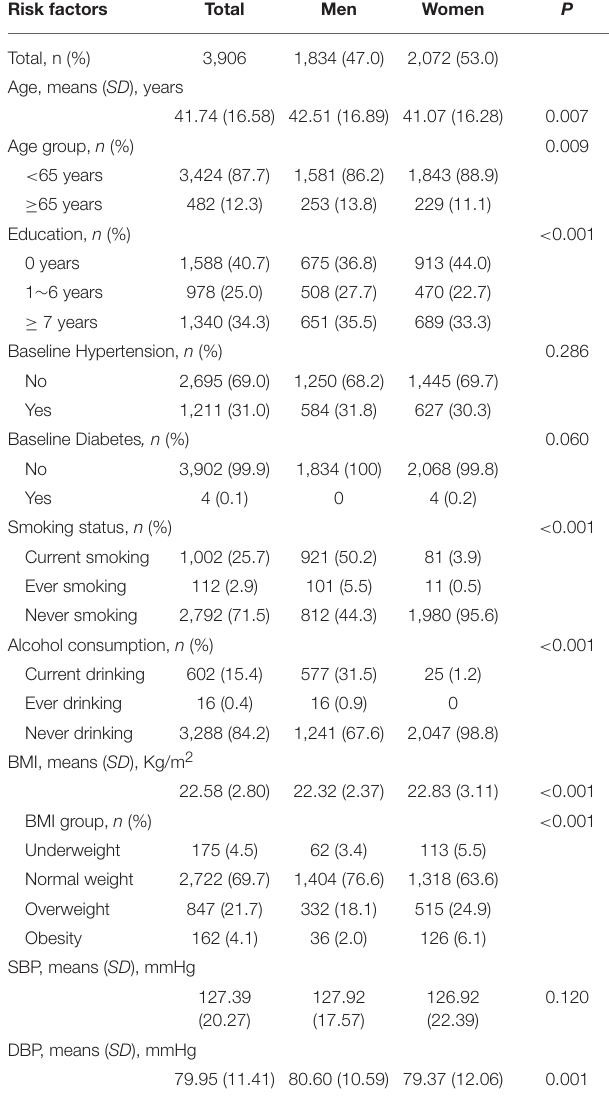
TABLE 1 | Demographic characteristics and risk factors of all participants in this